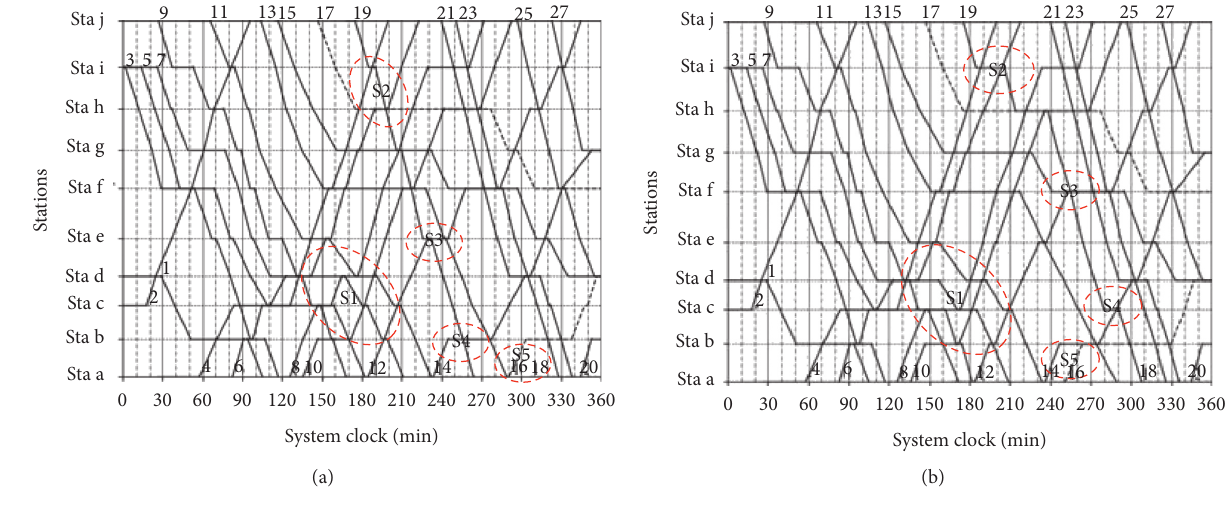
Figure 13: The adequate train timetables of (a) M.1 and (b) M.2 .